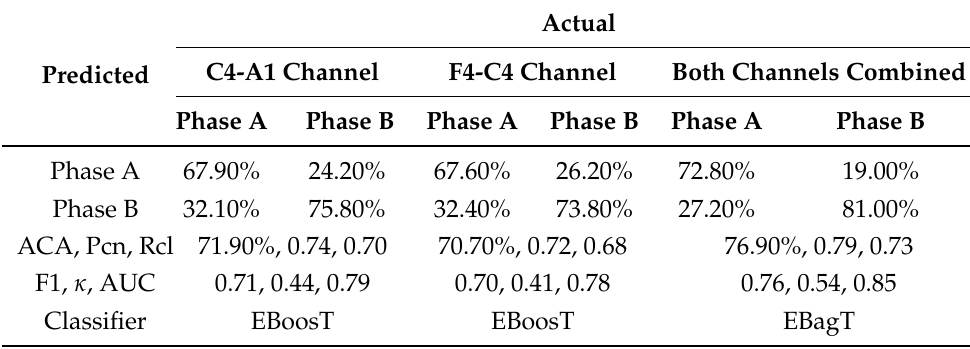
Table 8. Classification performance for PLM subjects.